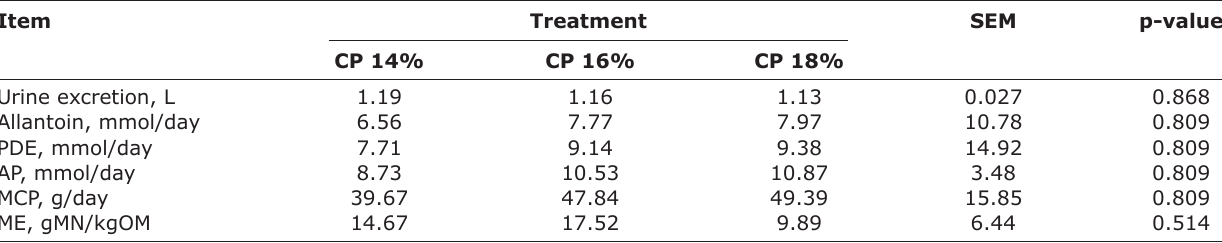
Table-4: Daily urine excretion, allantoin excretion, purine derivative excretion, absorbed purine, microbial crude protein, and microbial efficiency. Item